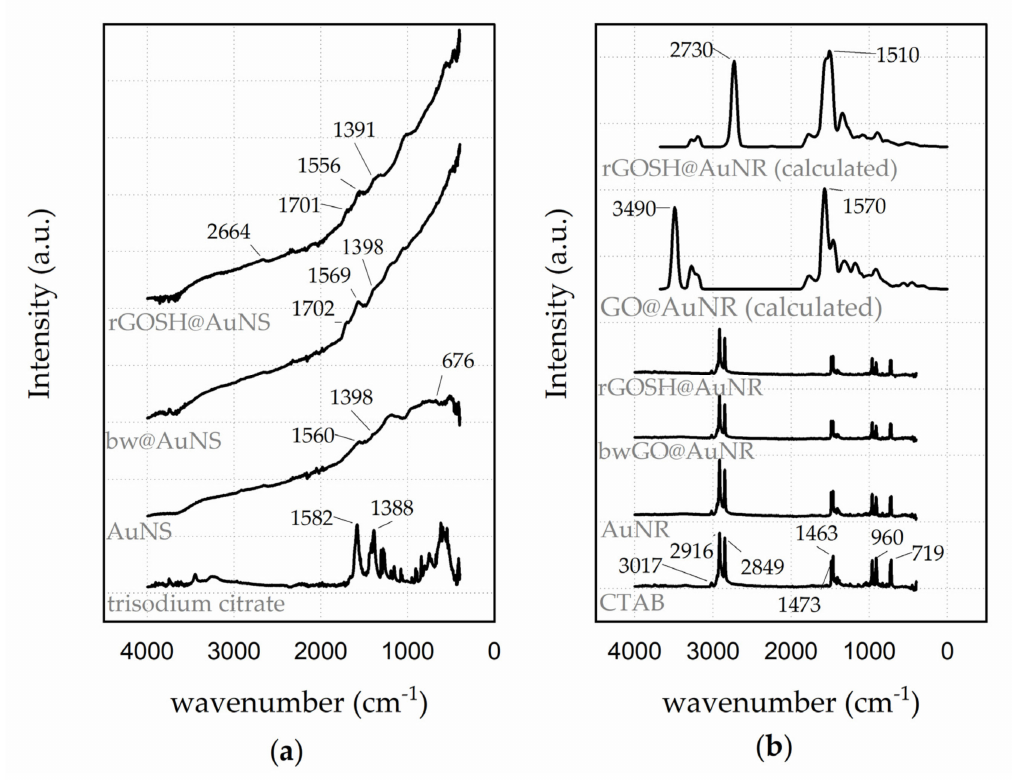
Figure 7. Infrared spectra of rGOSH in the comparison with GO: ( a ) Experimental ATR-FTIR spectra of citrate-capped AuNS and hybrid GO@AuNS samples in the comparison with trisodium citrate; ( b ) experimental and calculated IR spectra of AuNR and GO@AuNR hybrids in the comparison with cetyl trimethylammonium bromide (CTAB)